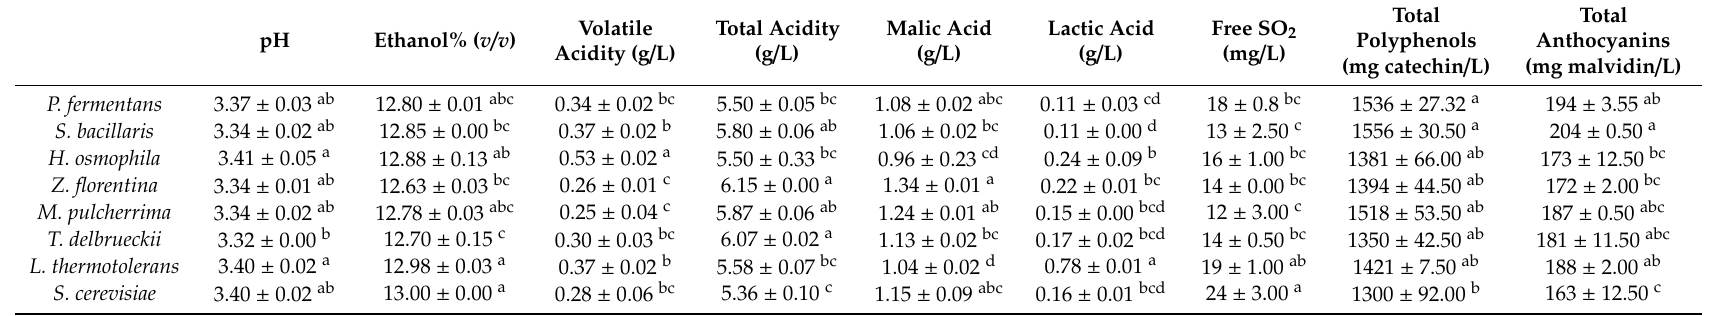
Table 2. Main analytical parameters of the wines evaluated before